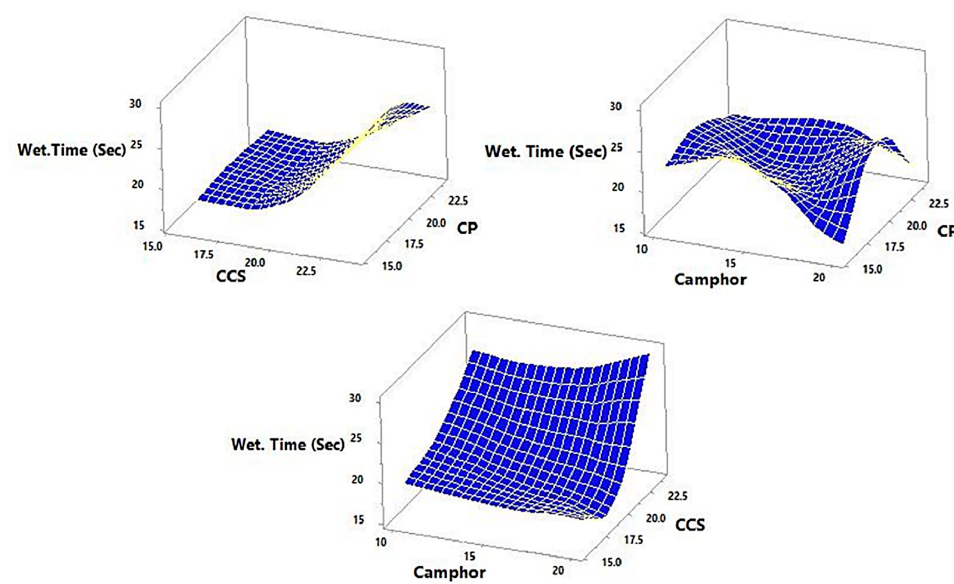
Figure 8. Shows the 3D and response surface plot for the effect super ‐ disintegrates (X 1 and X 2 ) and total amount of sublimating agents (X 3 ) on the response Y 4 (WT). WT is unaffected by raising CP from low to high levels when camphor is fixed at a medium level and CCS is low. WT fell from 29 to 24 s when CP climbed from low to high at a fixed medium level of camphor and with CCS at a high level. Furthermore, as CP climbed from low to high, WT reduced from 22 to 20 s at a set medium level of CCS and at a fixed low level of camphor. When CCS rose from low to high, WT increased from 19 to 27 s at fixed CP at medium level and a fixed high level of camphor. The hydrophilicity of excipients and the inner structure of tablets have a strong relationship with wetting time. The water infiltration rate into the powder bed is proportional to the pore radius, ac ‐ cording to Washburn’s equation, and is impacted by the hydrophilicity of powders, which is quantified by contact angle and surface tension [34]. It is self ‐ evident that increasing com ‐ pression force and/or decreasing porosity leads to smaller pore size and, as a result, higher WT [35].